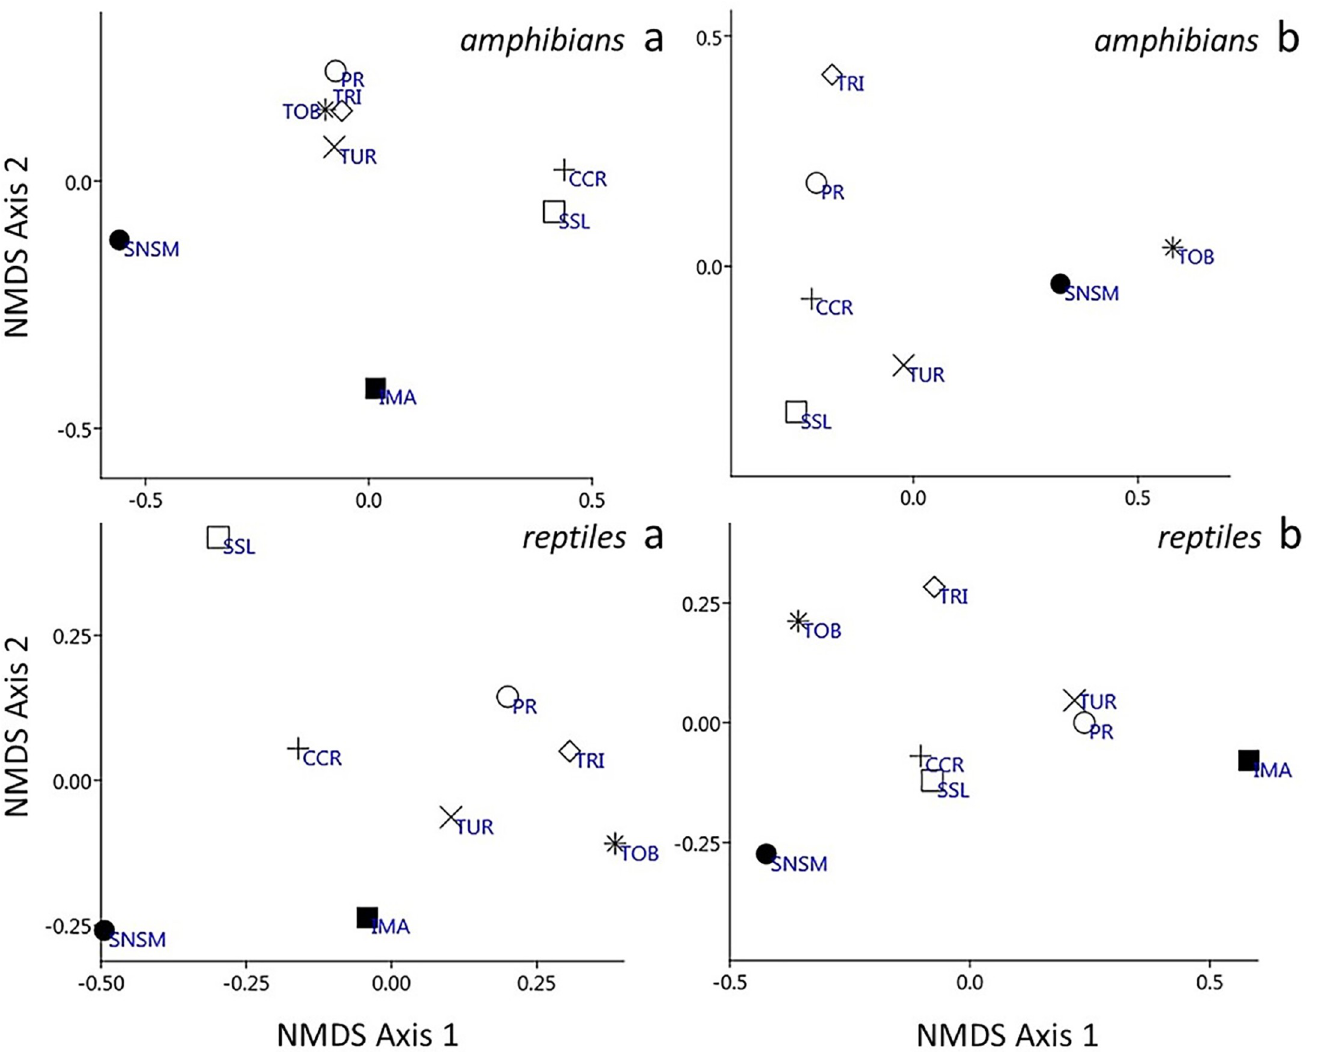
Fig 6. Metric multidimensional ordination and scaling (NMDS) based on the UPGMA algorithm and the Jaccard coefficient for amphibians and reptiles. The two graphs on the left are (a) amphibians (top) and reptiles (bottom) found above 200 m in elevation and the two graphs at the right labelled (b) are amphibians (top) and reptiles (bottom) found exclusively associated to mountain vegetation. SNSM (Sierra Nevada de Santa Marta, Colombia), SSL (Sierra de San Luis), CCR (Central Coastal Range), IMA (Isla de Margarita), TUR (Turimiquire Massif), PR (Paria Range), TRI (island of Trinidad), TOB (island of Tobago).